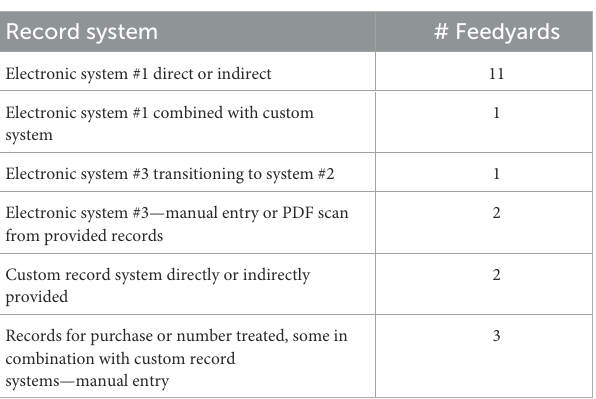
TABLE 2 Description of record